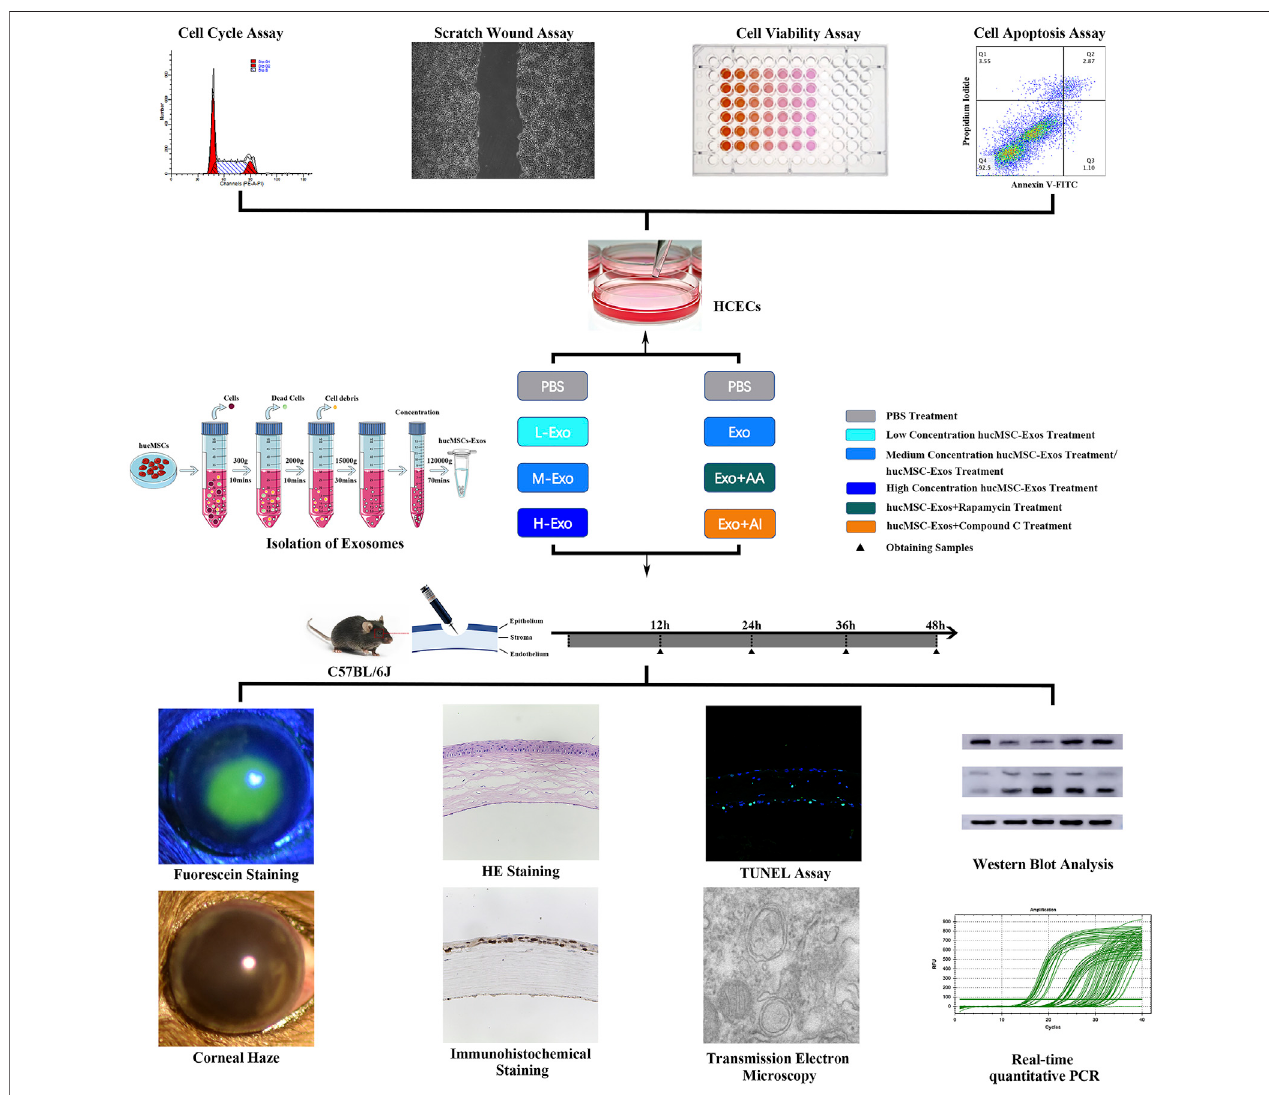
FIGURE 1 | Schematic protocol. Schematic representation of the isolation of the exosomes secreted from hucMSCs, in vitro experiments of HCECs, and in vivo experiments of corneal injury mouse.